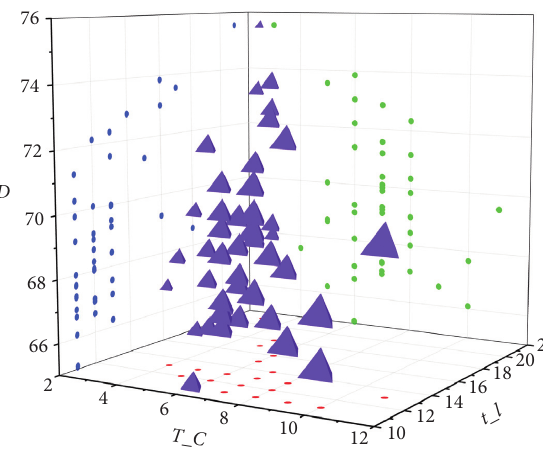
Figure 6: Communication frequency ( T_C )-the start-up time of overlapping ( t _1) – duration ( D ).